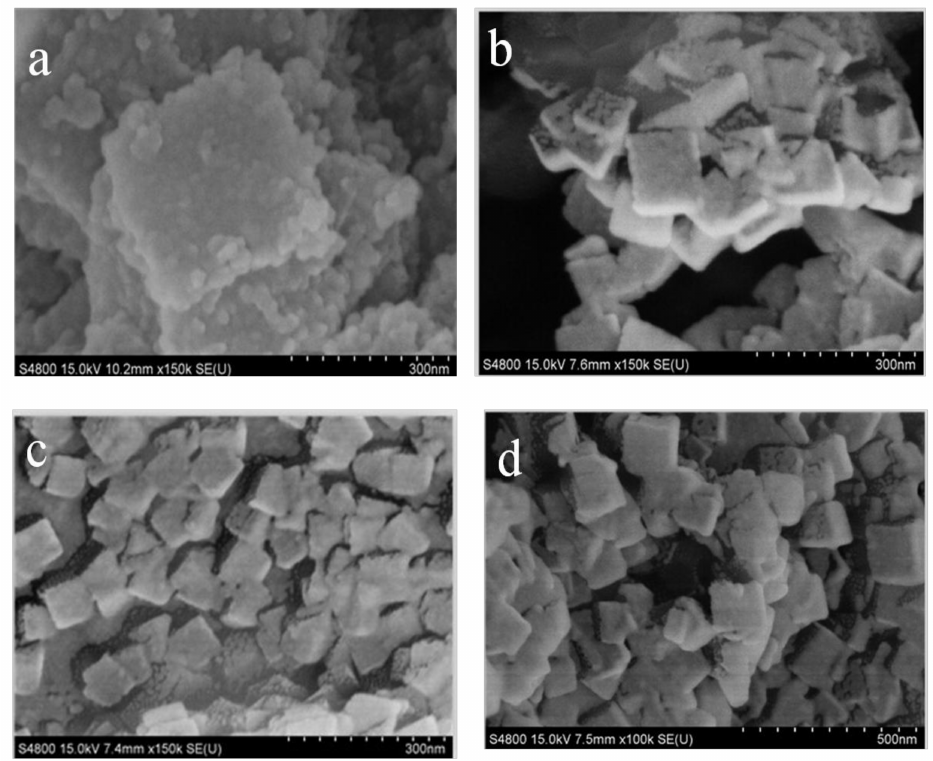
Figure 2. Scanning electron microscope (SEM) images of UiO-66 ( a ) [17]; UiO-66-NH 2 ( b ); UiO-66/GO ( c ) [17]; and UiO-66-NH 2 /GO ( d